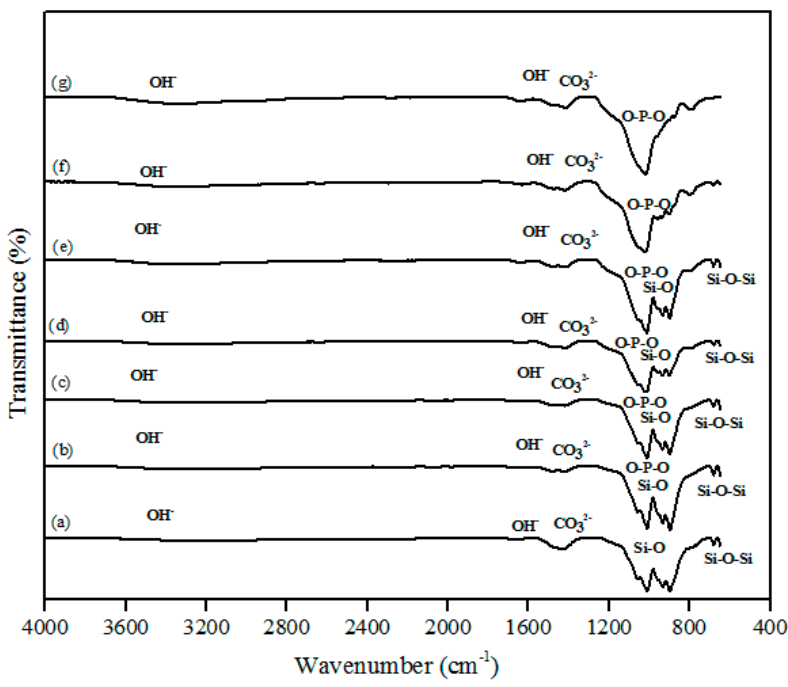
Figure 4. Fourier-transform infrared spectroscopy (FTIR) spectra of β -wollastonite ( a ) control sample and after soaking in the simulated body fluid (SBF) for ( b ) one; ( c ) three; ( d ) five; ( e ) seven; ( f ) 14; and ( g ) 21 days.